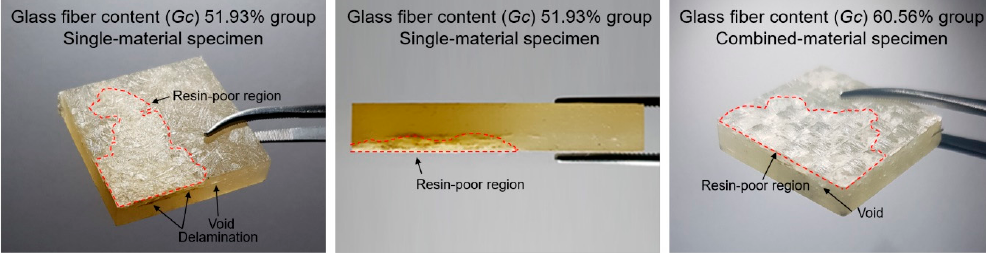
Figure 8. Defects in some example specimens.